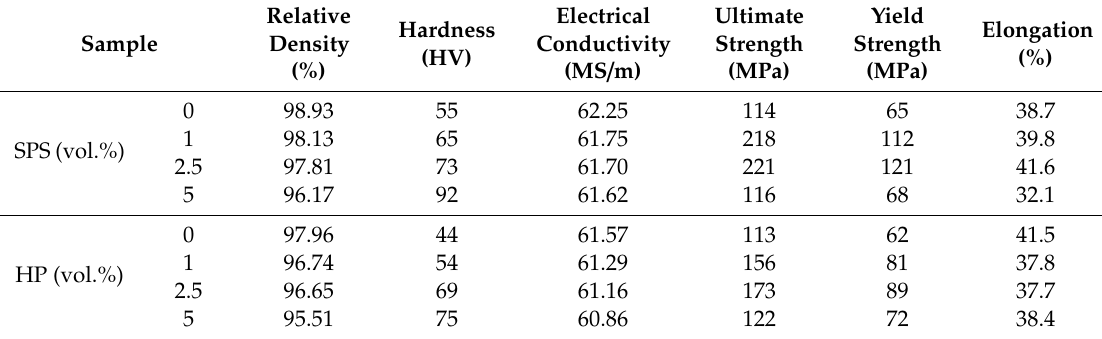
Table 1. Relative density, electrical conductivity and mechanical properties of the composites with di ff erent CNTs contents.